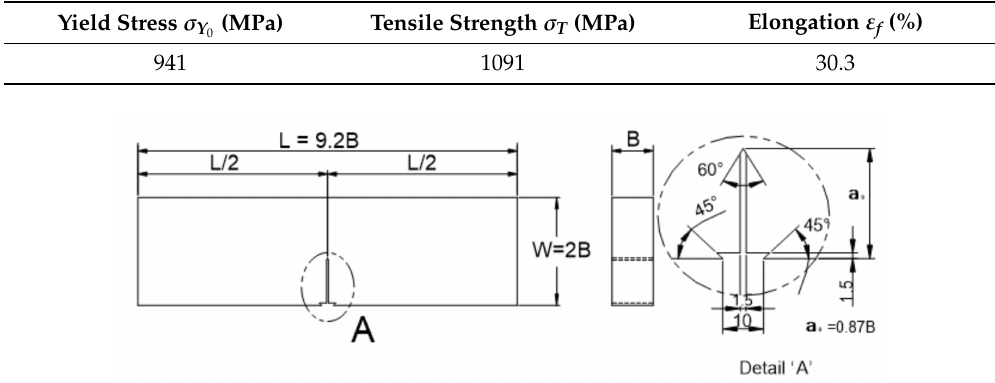
Figure 1. CTOD 3PB specimen (unit: mm).